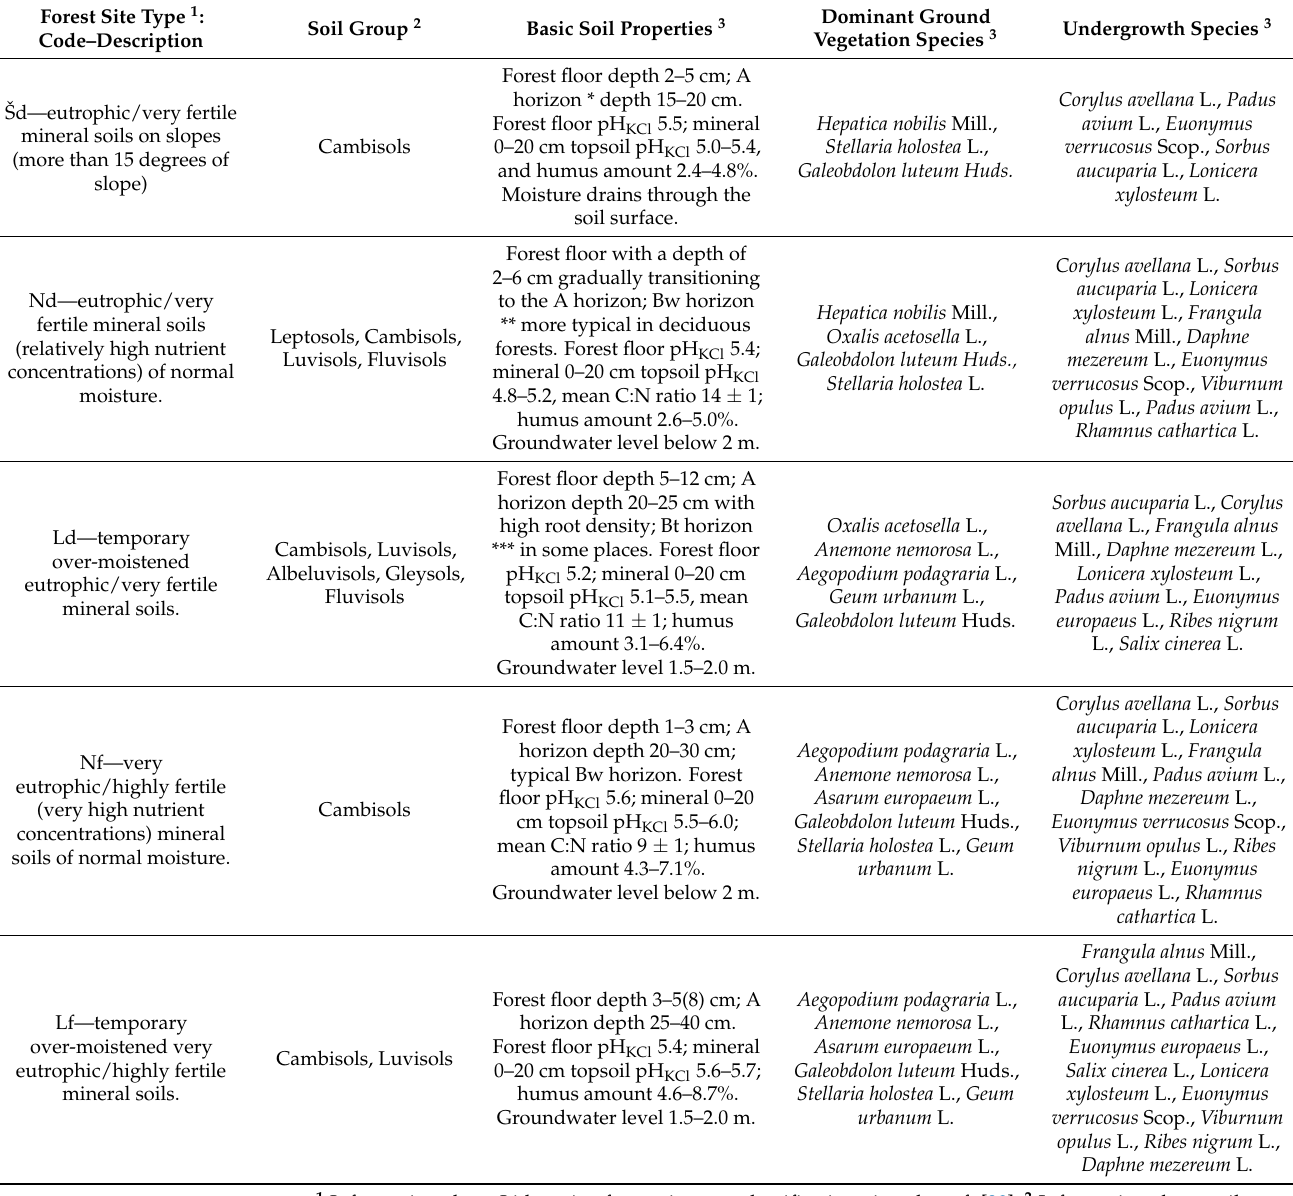
Table 1. Description of the forest site types according to the Lithuanian forest site type classification used for the selection of forest stands in this study. The given soil and vegetation characteristics describe typical very fertile forest site types in